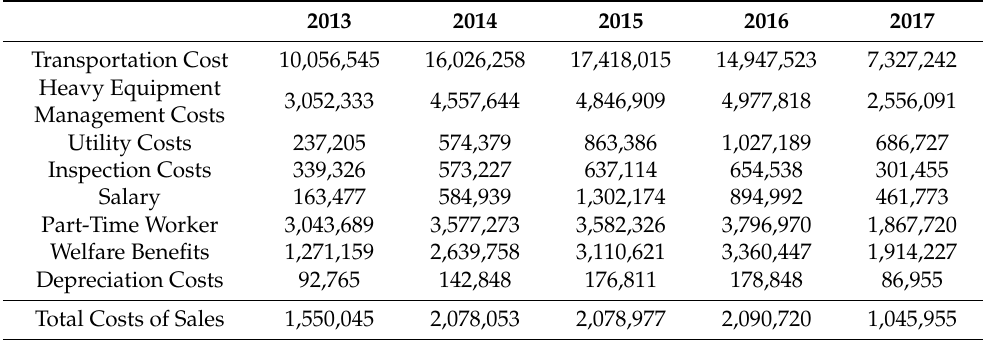
Table 7. Calculation of total cost of sales per year proposed by the PRSOC (unit: U.S.